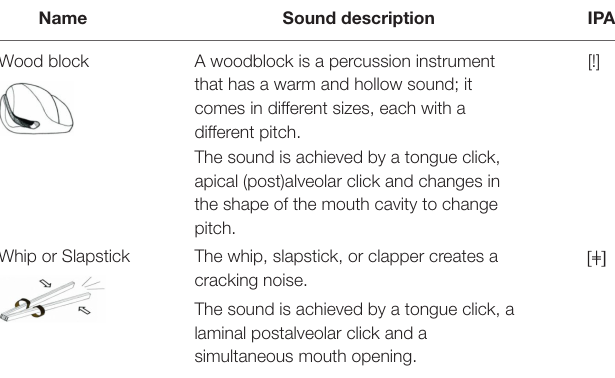
TABLE 2 | Additional sounds (IPA, 2015).